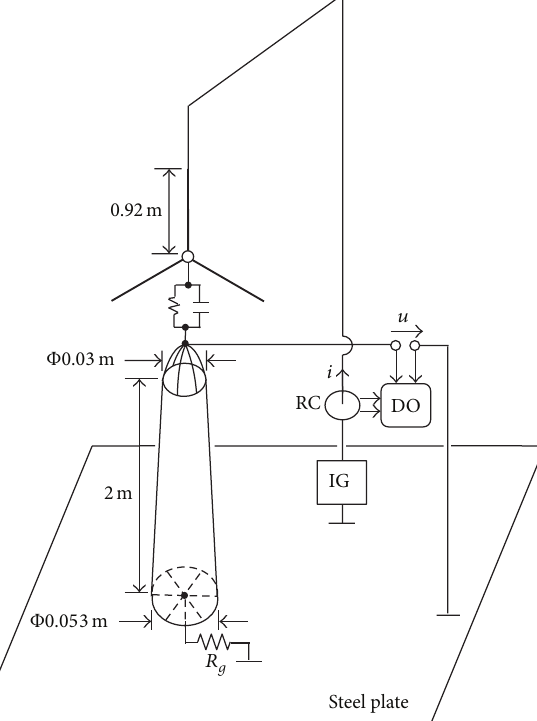
Figure 10: Experimental setup (RC: Rogowski coil; DO: digital oscilloscope; IG: impulse